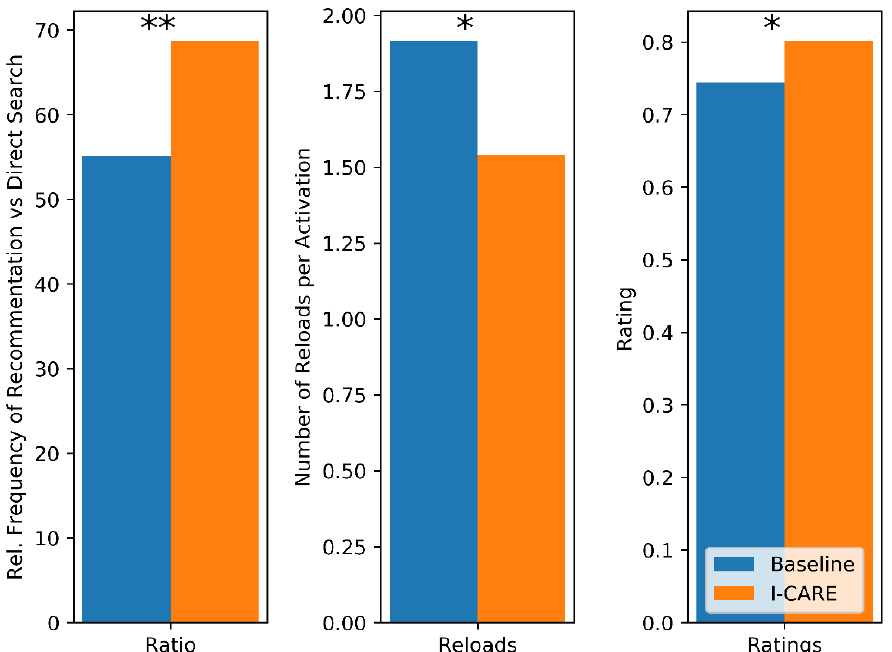
Figure 9. Different performance metrics for the comparison of Baseline Recommender and I-CARE recommender. (*) denotes a significant difference ( p < 0.05), (**) denotes a highly significant difference ( p < 0.001).